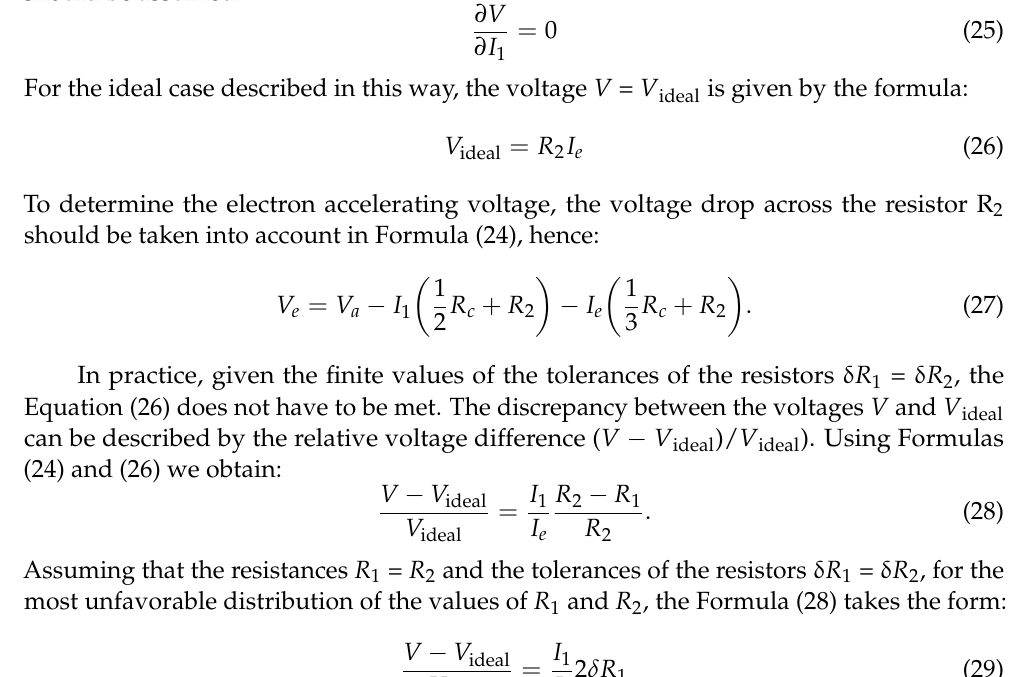
d = 1.2 × 10 − 4 m and a length of l = 4.5 × 10 − 2 m, surface-coated with materials with the electron work function ϕ in the range from 0.9 eV to 4.5 eV were used. The calculations were made for the set values of the intensity of the emission current: I e = 1 mA, I e = 10 mA, I e = 50 mA, and I e = 100 mA. The results are shown in Table